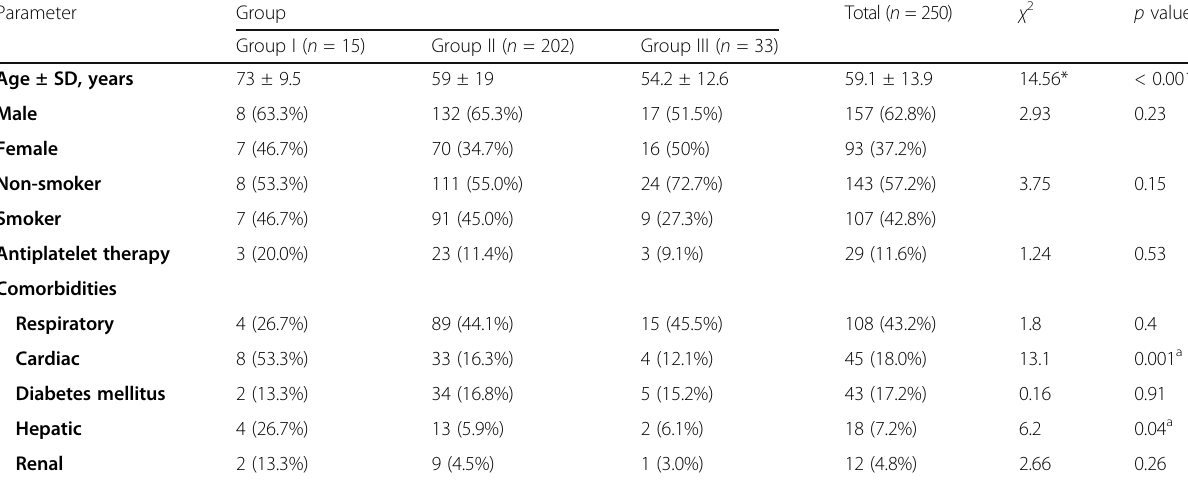
Table 1 Sociodemographic data of all studied patients Parameter